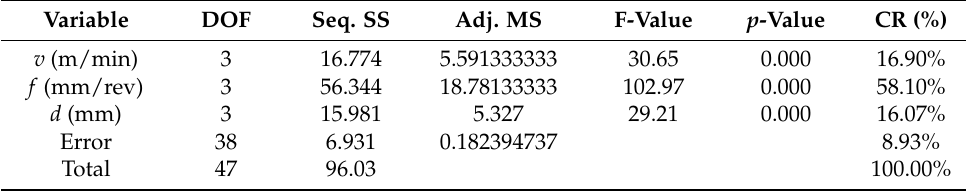
Table 10. Analysis of variance and percentage contribution results for Ra.